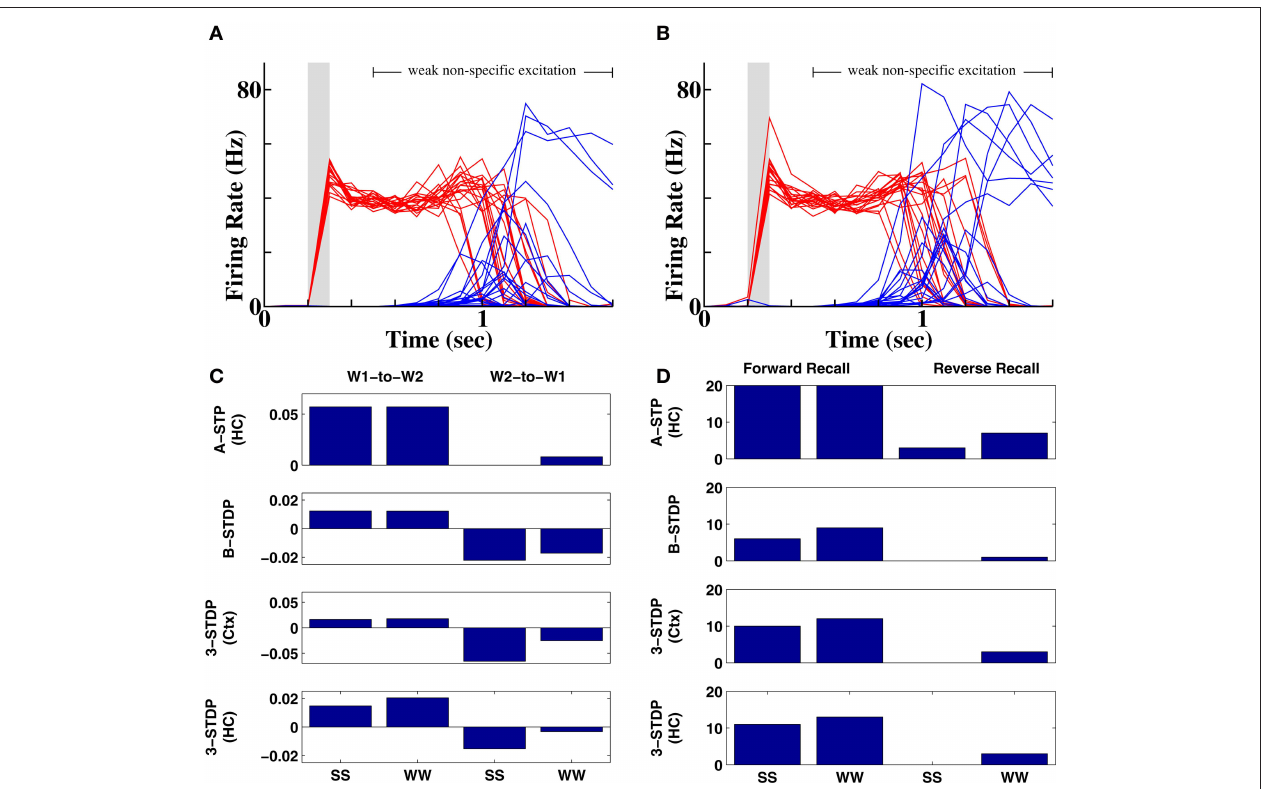
Figure 3 | impossibility of reverse recall via connections between word populations. (A) 20 separate instantiations of the memory protocol, with activation of the second word produce chance recall of other words (3 out of 20 instantiations). In the unsuccessful examples, pools that did not receive prior input become activated by chance during recall. (B) Reverse recall is slightly greater than chance following weak inputs, where temporal overlap of activity is greater. (C) Comparison of changes in mean synaptic weight as a fraction